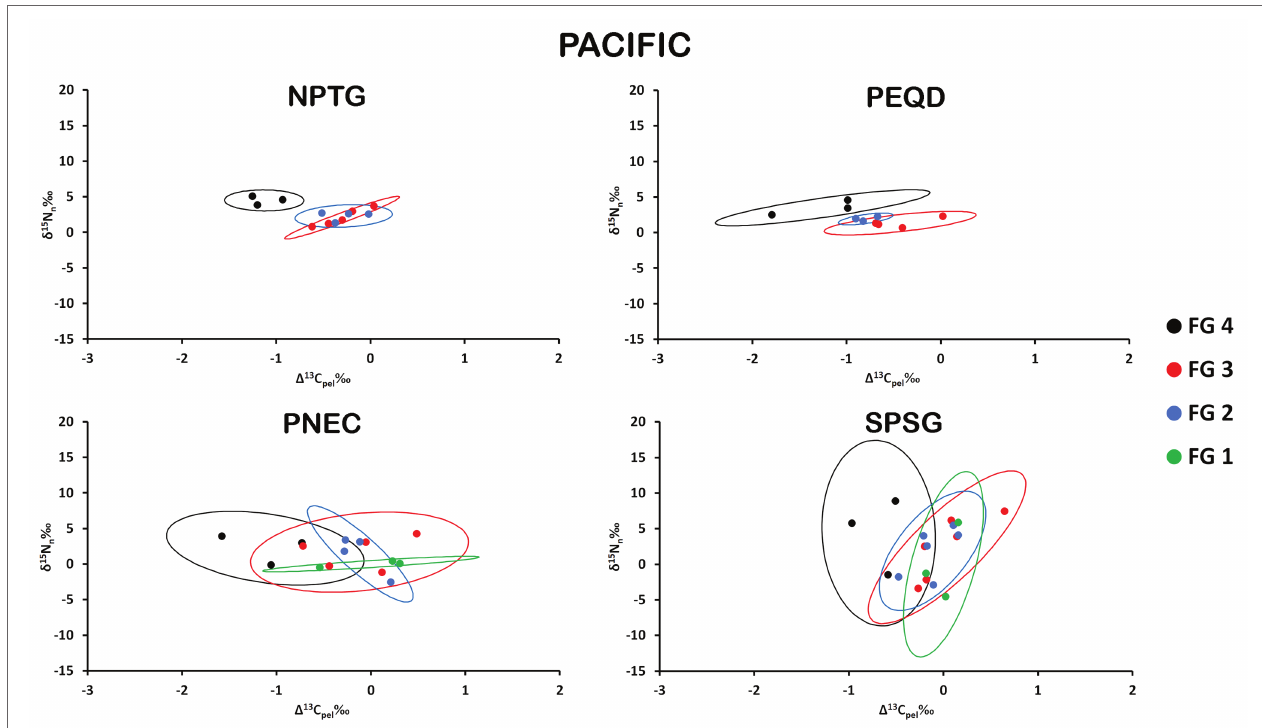
FIGURE 5 | Isospace of Δ 13 C pel and δ 15 N n including individual sample normalized values of neustonic zooplankton for biogeochemical provinces in the Pacific Ocean: NPTG, PEQD, PNEC, and SPSG. The maximum likelihood estimates of the standard ellipse areas (thick lines) for each FG are shown. FG 1 = detritivores; FG 2 = herbivores/omnivores; FG 3 = carnivores; FG 4 = predators. Decreases in Δ 13 C pel reflect increases in raw δ 13 C values due to normalization.